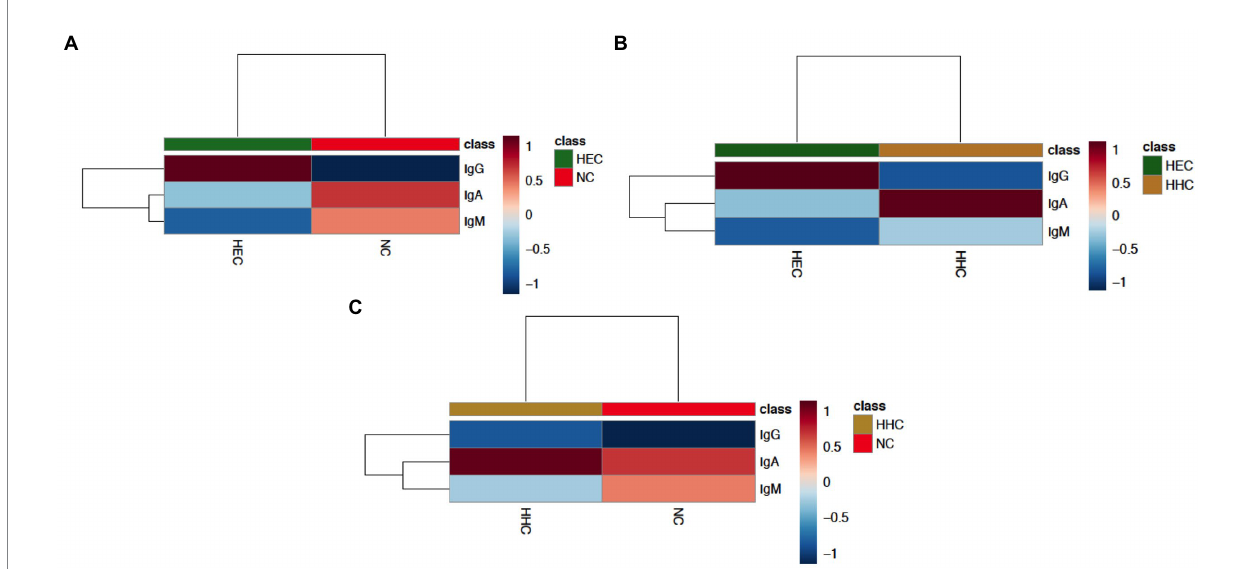
FIGURE 5 The indexes of anti-Mce1A biomarkers can cluster hierarchically. The Clustering result is shown as a dendrogram and heatmap (distance measure using similarity measure - Euclidean distance, and algorithm using clustering to minimize the sum of squares of any two clusters - Ward’s linkage). Hierarchical cluster analysis was performed using normalized and transformed antibody indexes. Each sample begins as a separate cluster and the algorithm proceeds to combine them until all samples belong to one cluster for HEC and NC (A) , HEC and HHC (B) , and HHC and NC (C) . The heatmap shows the